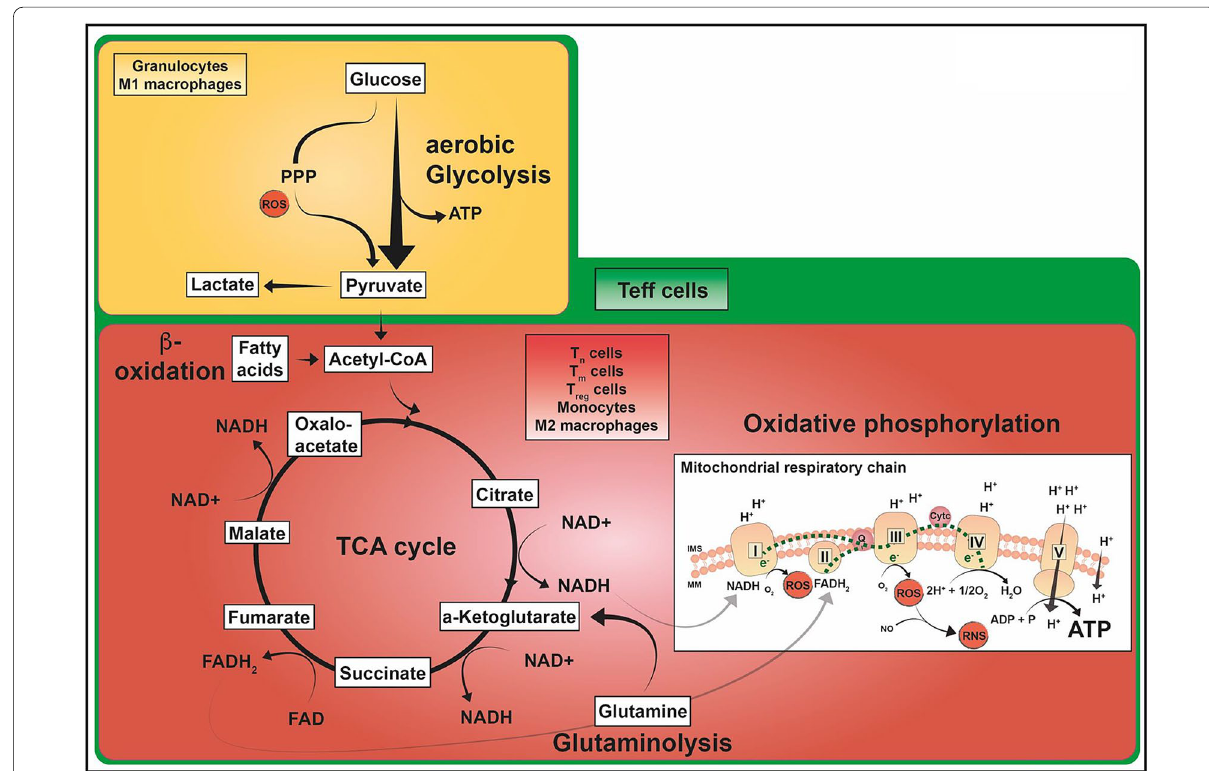
Fig. 5 ATP-producing metabolic pathways in distinct immune cell subsets. Glucose oxidation to pyruvate via glycolysis is a fast reaction generating 2 mol of ATP per mol glucose. This aerobic glycolysis is complemented by the PPP that can produce further metabolic precursor molecules and is involved in ROS production. Pyruvate can be converted to lactate or further oxidized to acetyl-CoA entering the mitochondrial TCA cycle (yellow box). The TCA cycle (red box) generates reducing equivalents NADH and FADH2 which are utilized in the mitochondrial respiratory chain to build up the proton gradient across the mitochondrial inner membrane by complexes I–IV of the respiratory chain. As a by-product, ROS and RNS are produced. OXPHOS produces larger amounts of ATP (~ 30 mol/mol glucose) by complex V. Immune cells are also able to utilize substrates such as glutamine, which enters these pathways via the TCA metabolite α-ketoglutarate and FA, which are oxidized to acetyl-CoA via β-oxidation. Granulocytes and M1 macrophages (yellow box) have a highly glycolytic metabolism even when O 2 is available. Their TCA cycle and respiratory chain activity are maintained at a low level. T n , T m , and T reg cells, as well as monocytes and M2 macrophages, primarily perform OXPHOS and are also able to metabolize FA and glutamine in order to fuel the TCA cycle (red box). T eff cells (green box) have a highly active metabolism including all of the pathways described. ADP adenosine diphosphate, ATP adenosine triphosphate, CoA coenzyme A, FADH 2 /FAD flavin adenine dinucleotide in its reduced/oxidized form,